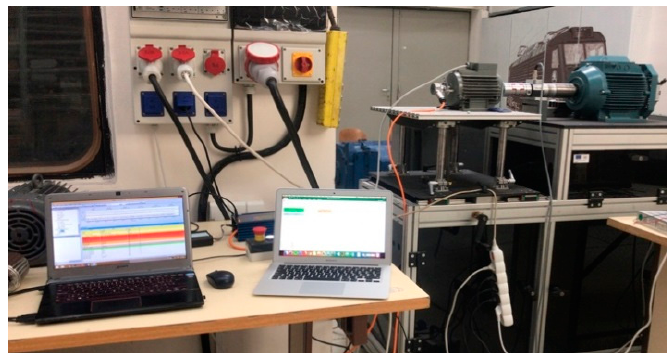
Figure 6. Experimental setup of dynamometer and RSM.